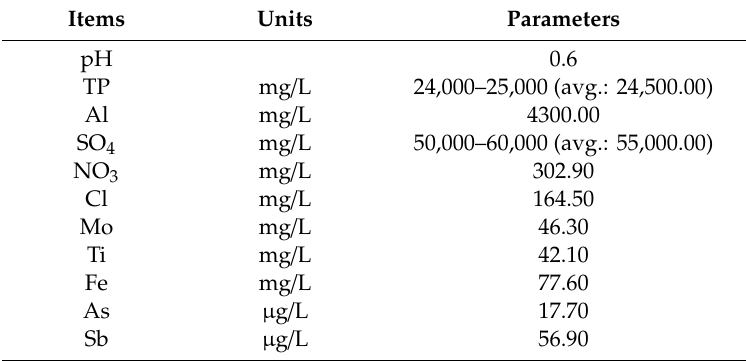
Table 1. The parameters of the wastewater